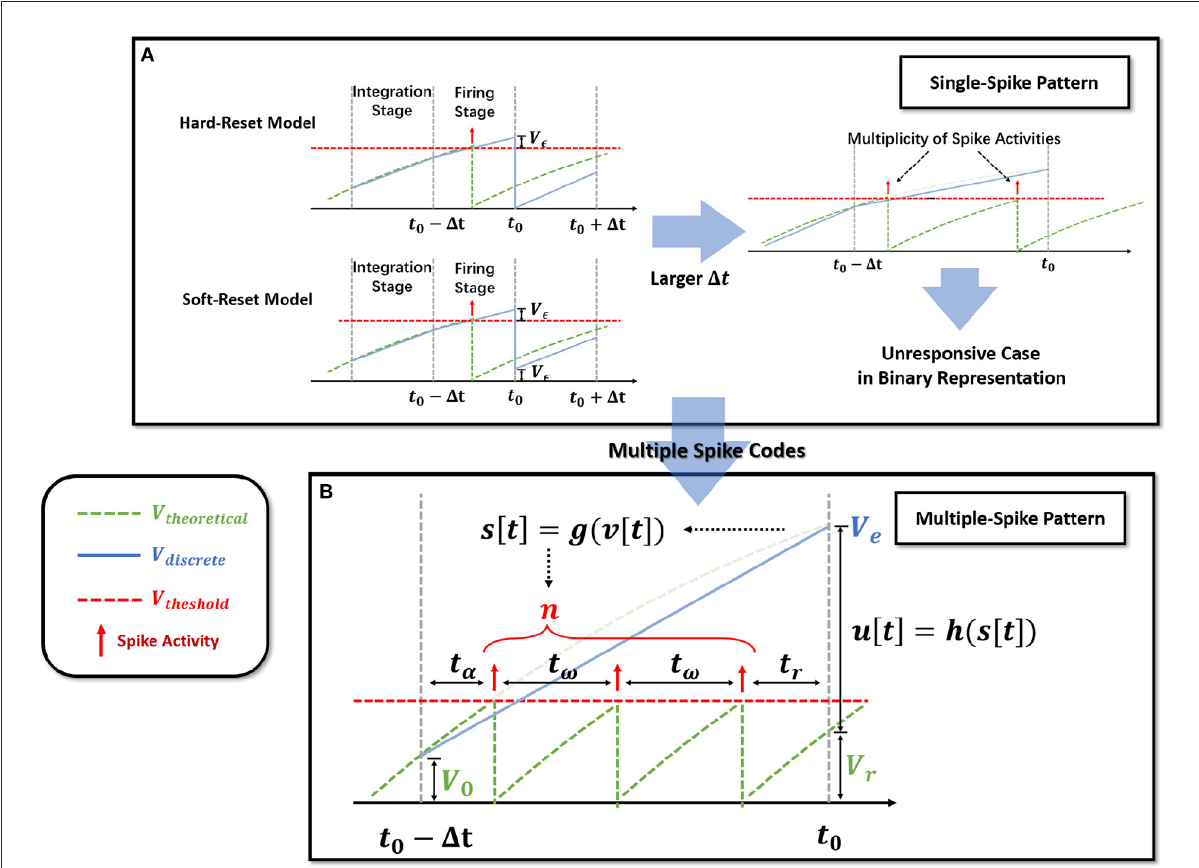
FIGURE2 Extension of the single-spike pattern (SSP) to multiple-spike pattern (MSP). (A) Modeling LIF neural dynamics with Hard-Reset Model and Soft-Reset Model, which derives the multiplicity issue with larger 1 t . (B) Extending the SSP into MSP with integer transmission, which estimates the number of spike activities inside a 1 t time